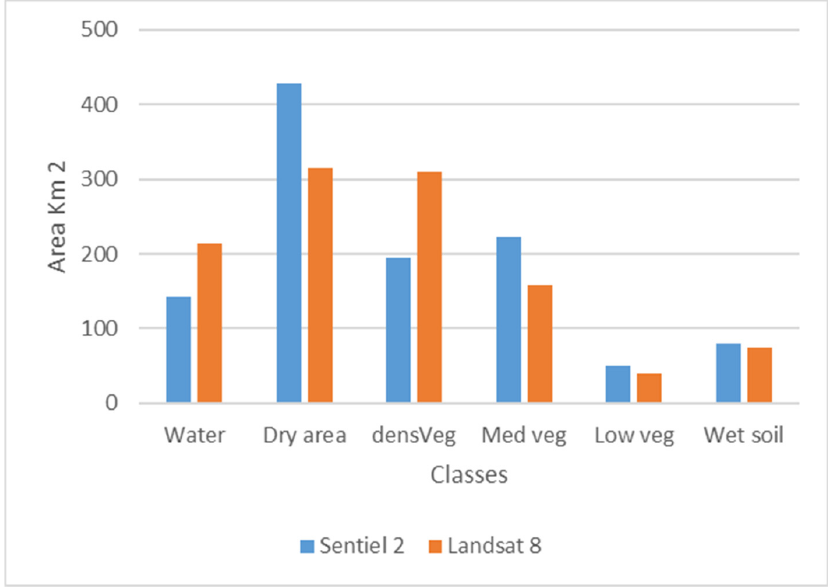
Figure 11. Histograms of the two classification results for Figure 10.